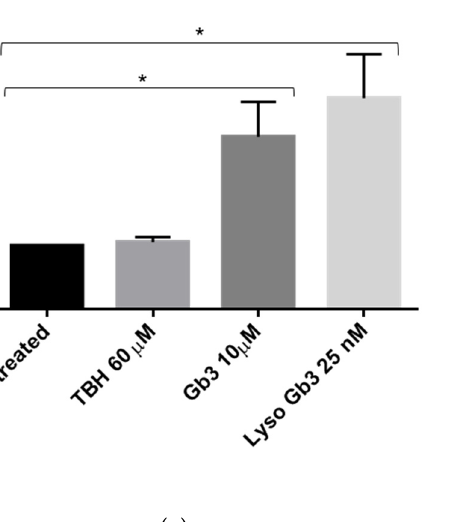
Figure 8. Lyso-Gb3 and GB3 effect on HUVECs senescence. Senescence status was estimated by SA- β -Gal assay in HUVECs treated with TBH 60 µM, Lyso-Gb3 25 nM, and Gb3 10 µM. Images are representative of ten random fields ( a ). Data are expressed as % of SA-b-Gal positive cells and are the means ± SD ( b ). Comparison among multiple groups was analyzed by one-way analysis of variance, followed by Bonferroni’s post hoc test. * p < 0.01.